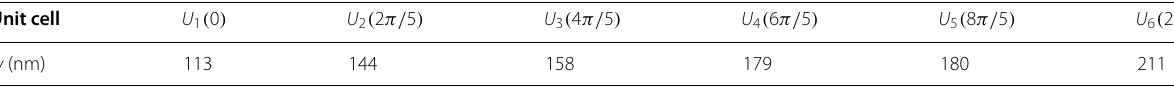
Table 1 The side lengths of the regular hexagonal nanorods Unit cell